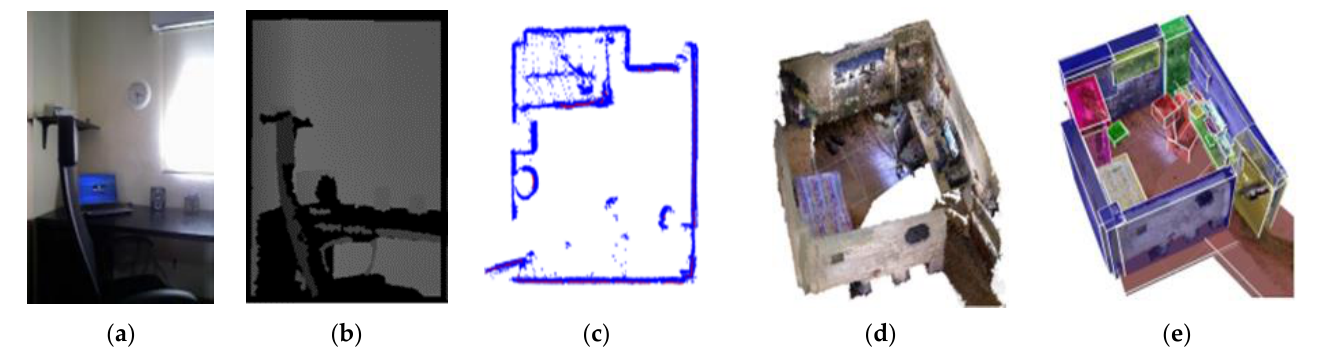
Figure 2. Several types of data provided by the Robot-at-Home dataset: ( a ) RGB image, ( b ) depth image, ( c ) 2D LiDAR map, ( d ) 3D room reconstruction, and ( e ) 3D room semantic reconstruction [108].